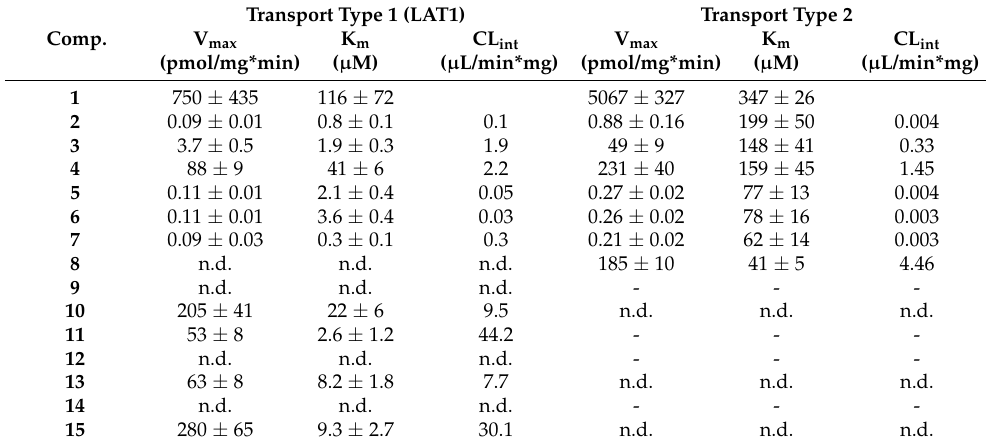
Table 3. Michaelis-Menten kinetic parameters (V max , K m , and CL int ) calculated from the Eadie– Hofstee plot analysis of transporter-mediated cellular uptake of studied compounds 1 – 15 (1–200 µ M). The data are presented as mean ± SD, n = 3, and n.d. denotes a possible autoactivation mechanism.